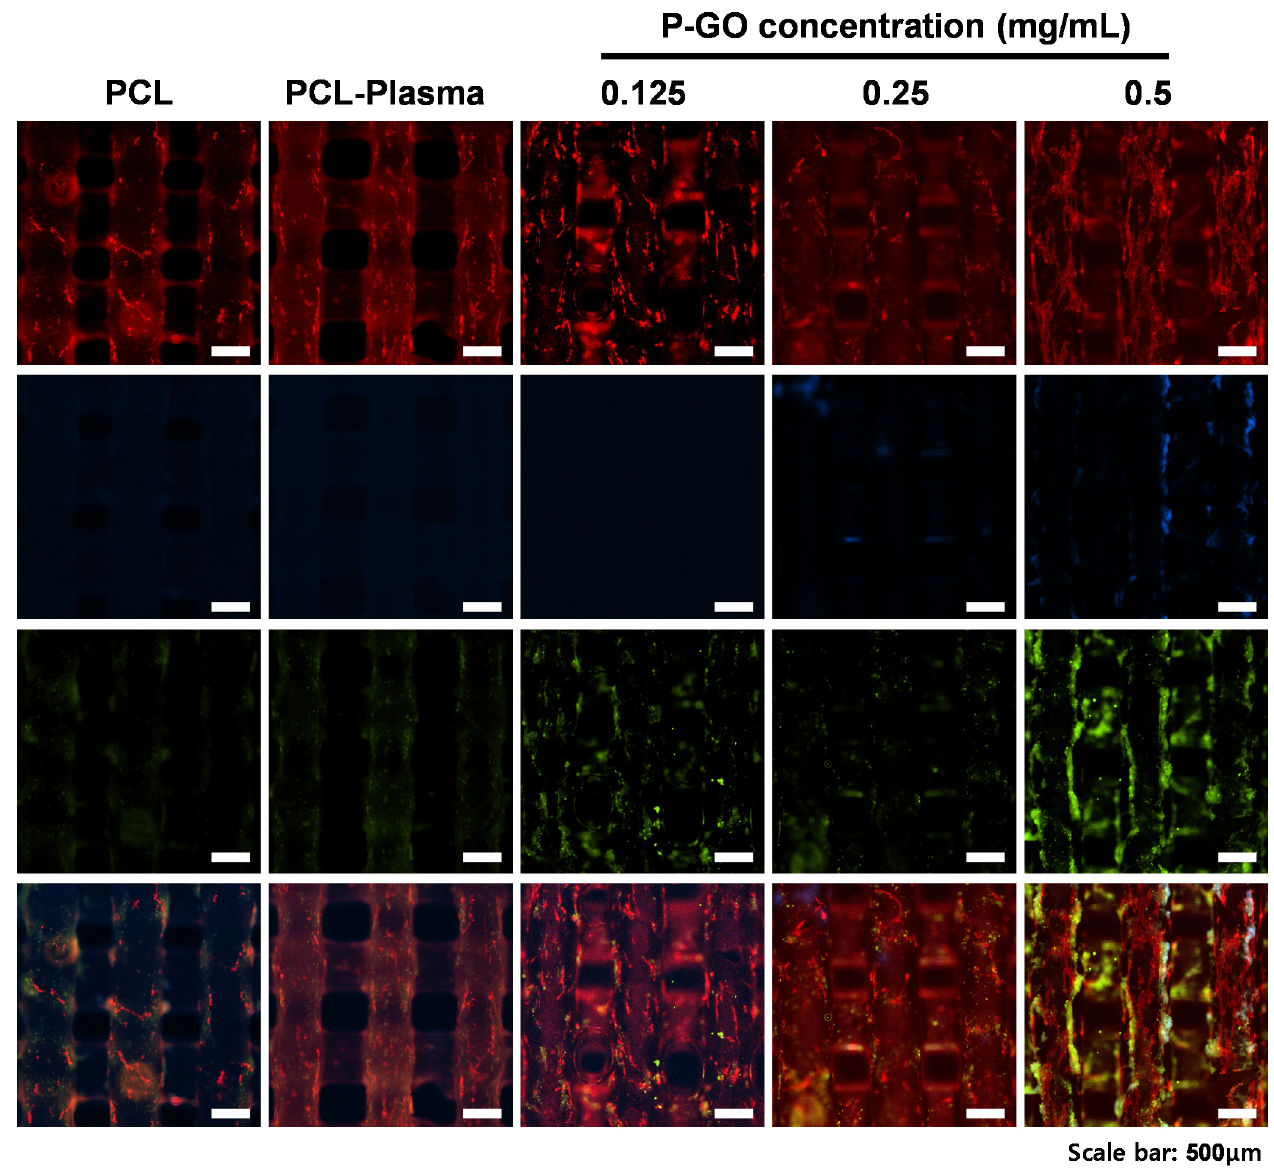
Figure 7. Immunofluorescence images of the scaffolds on day 20. Osteopontin (OPN), actin, and cell nuclei (DAPI) were exhibited as red, green, and blue, respectively. Scale bars; 500 μ m.